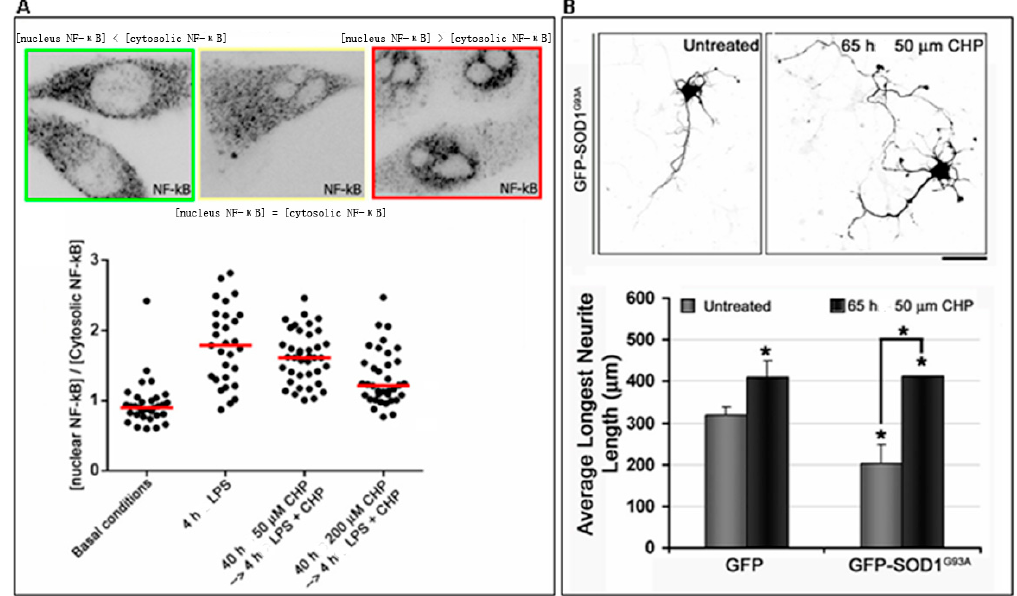
Figure 4. Role of cyclo(His-Pro) in ALS. ( A ) Cyclo(His-Pro) prevents the toxic effects of mutant SOD1 in microglia. Microglial cells immortalized from neuronal primary cultures derived from SOD1 G93A transgenic mice were pre-treated with 50 or 200 μ M cyclo(His-Pro) (40 h) prior to 1 μ g/mL LPS exposure in serum-free medium. Representative immunofluorescence images were quantitatively analyzed to classify the cells into three different categories on the basis of the NF- κ B distribution between the nucleus and cytoplasm (magnification: 65×). The scatter plot of the effects of increasing the concentration of cyclo(His-Pro) on NF- κ B distribution; ( B ) Cyclo(His-Pro) prevents the toxic effects of mutant SOD1 in neurons. Primary cortical neurons were transfected after one day in vitro with GFP or GFP-SOD1 G93A and fixed with paraformaldehyde at Day 4 in vitro. Representative immunofluorescence images of neurons expressing GFP-SOD1 G93A untreated or treated for 65 h with 50 µ m cyclo(His-Pro) are shown. Bar: 50 µ m. Images of GFP- or GFP-SOD1 G93A transfected neurons were quantitatively analyzed to assess the length of the longest neurite. Data represent the mean ± s.e.m. of at least three independent experiments. Student’s t : * p < 0.05 vs. GFP-transfected neurons.